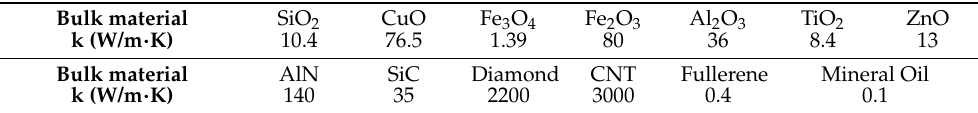
Table 4. Thermal conductivities of nanoparticles and dielectric